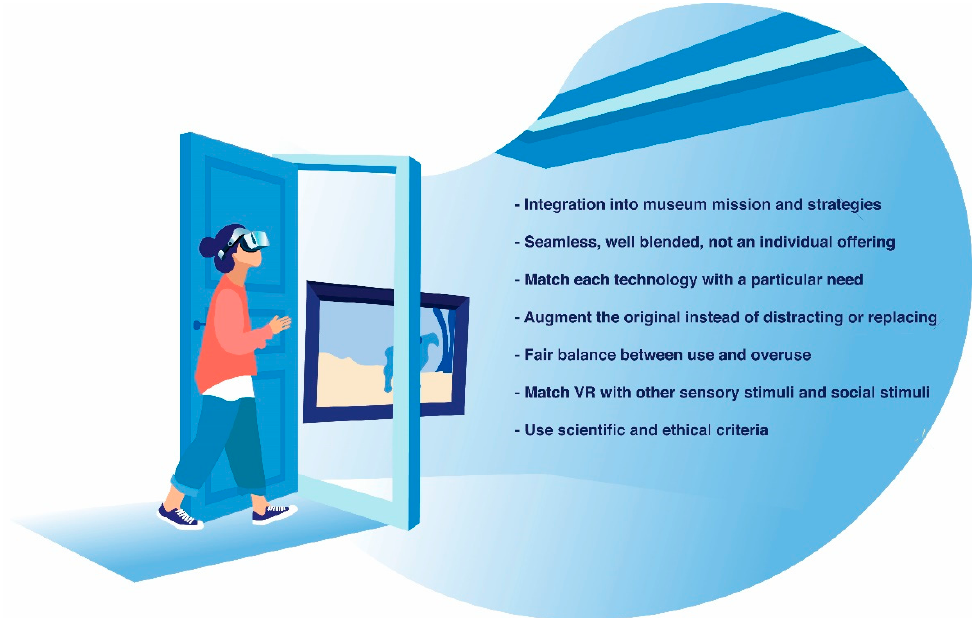
Figure 3. Summary of proposed suggestions for designing and developing VR experiences in museums.